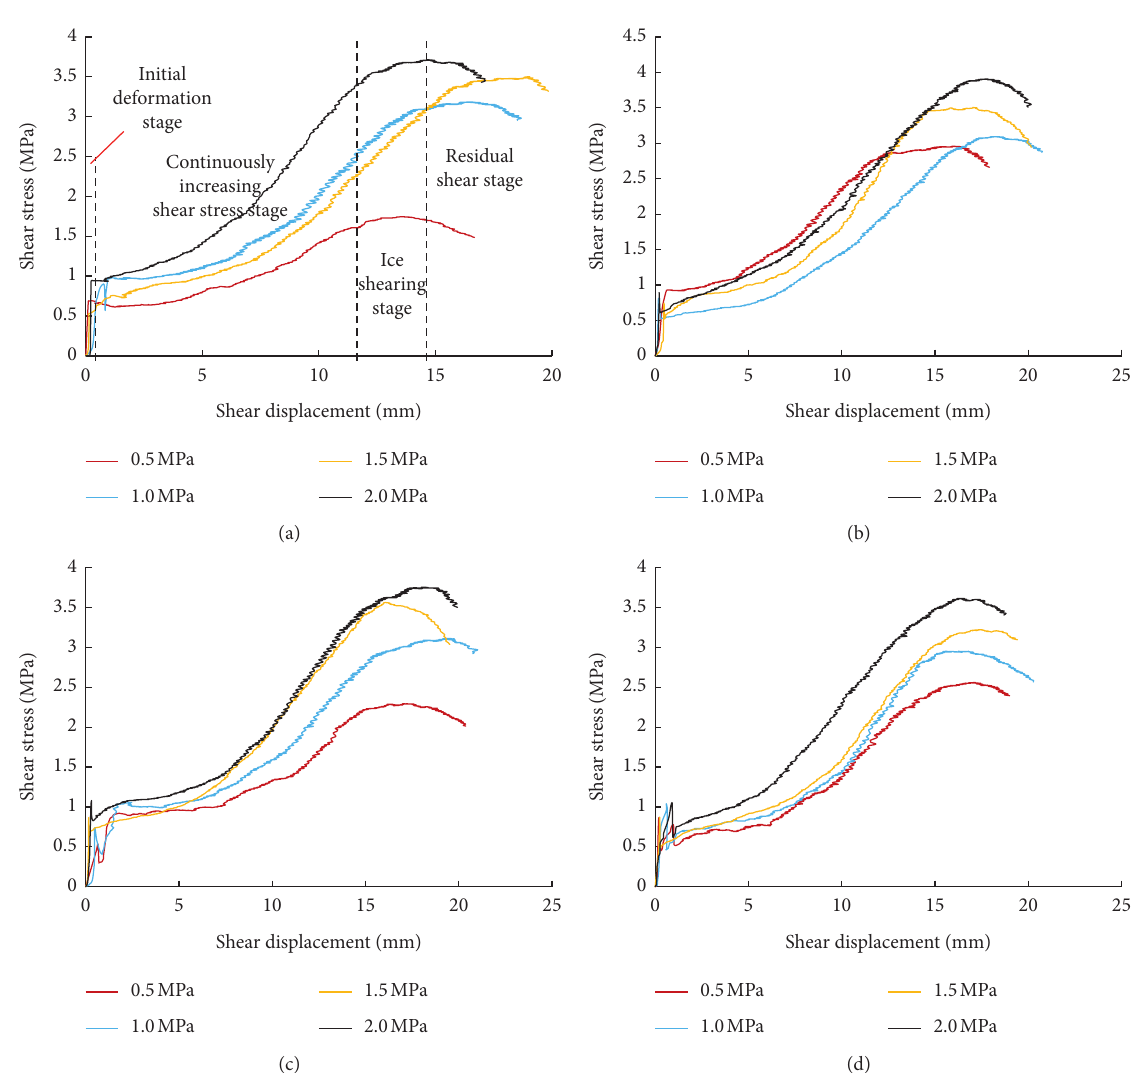
Figure 7: Shear stress-shear displacement curves of different normal stress joints with 7mm opening degree. (a) Specimen 1#. (b) Specimen 2#. (c) Specimen 3#. (d) Specimen